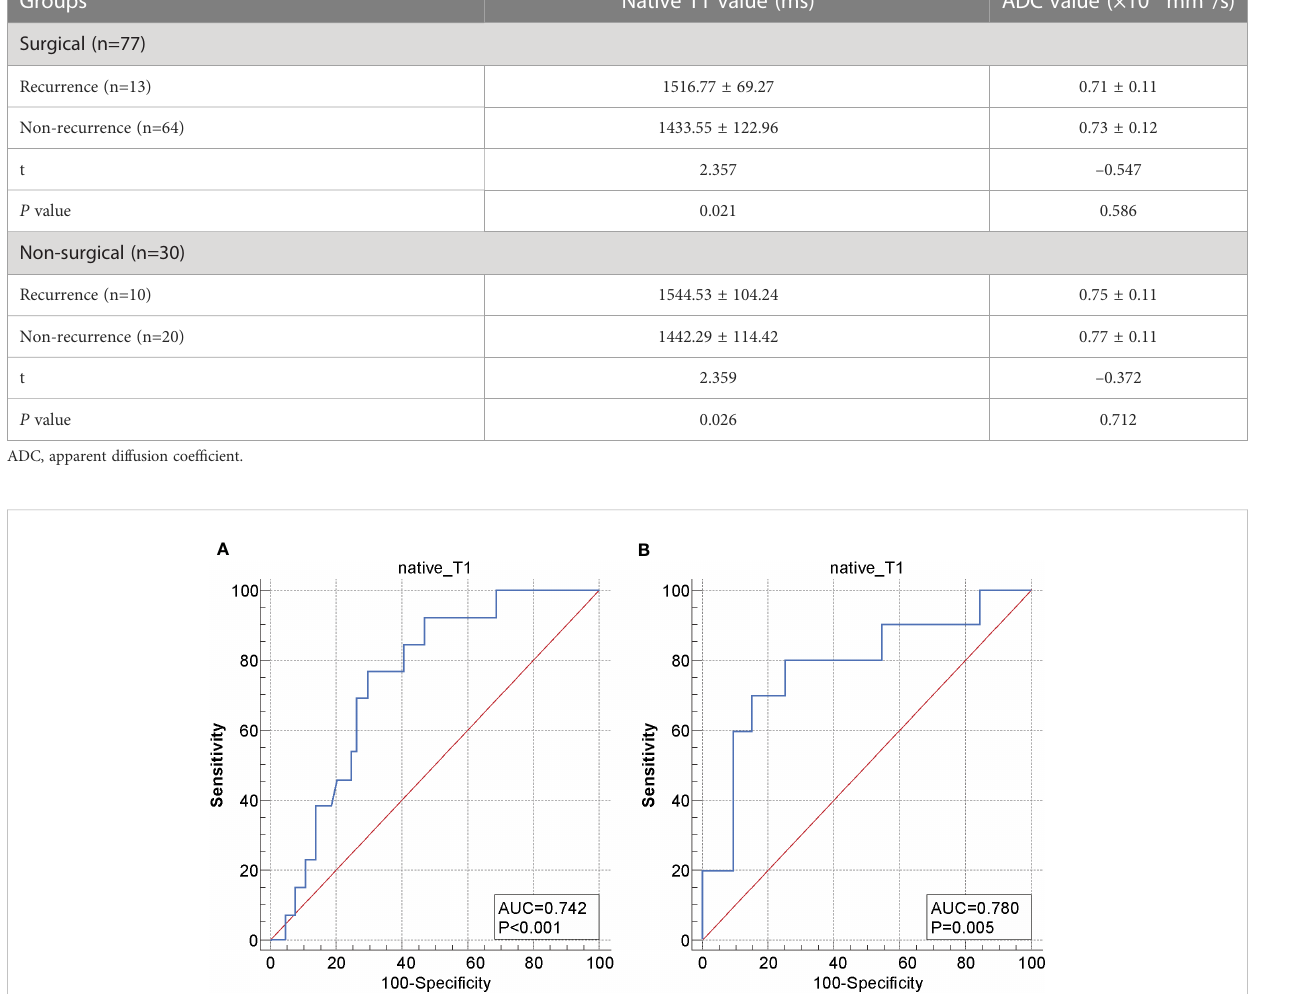
TABLE 3 Comparison of the native T 1 values of the recurrence and non-recurrence subgroups after treatment.